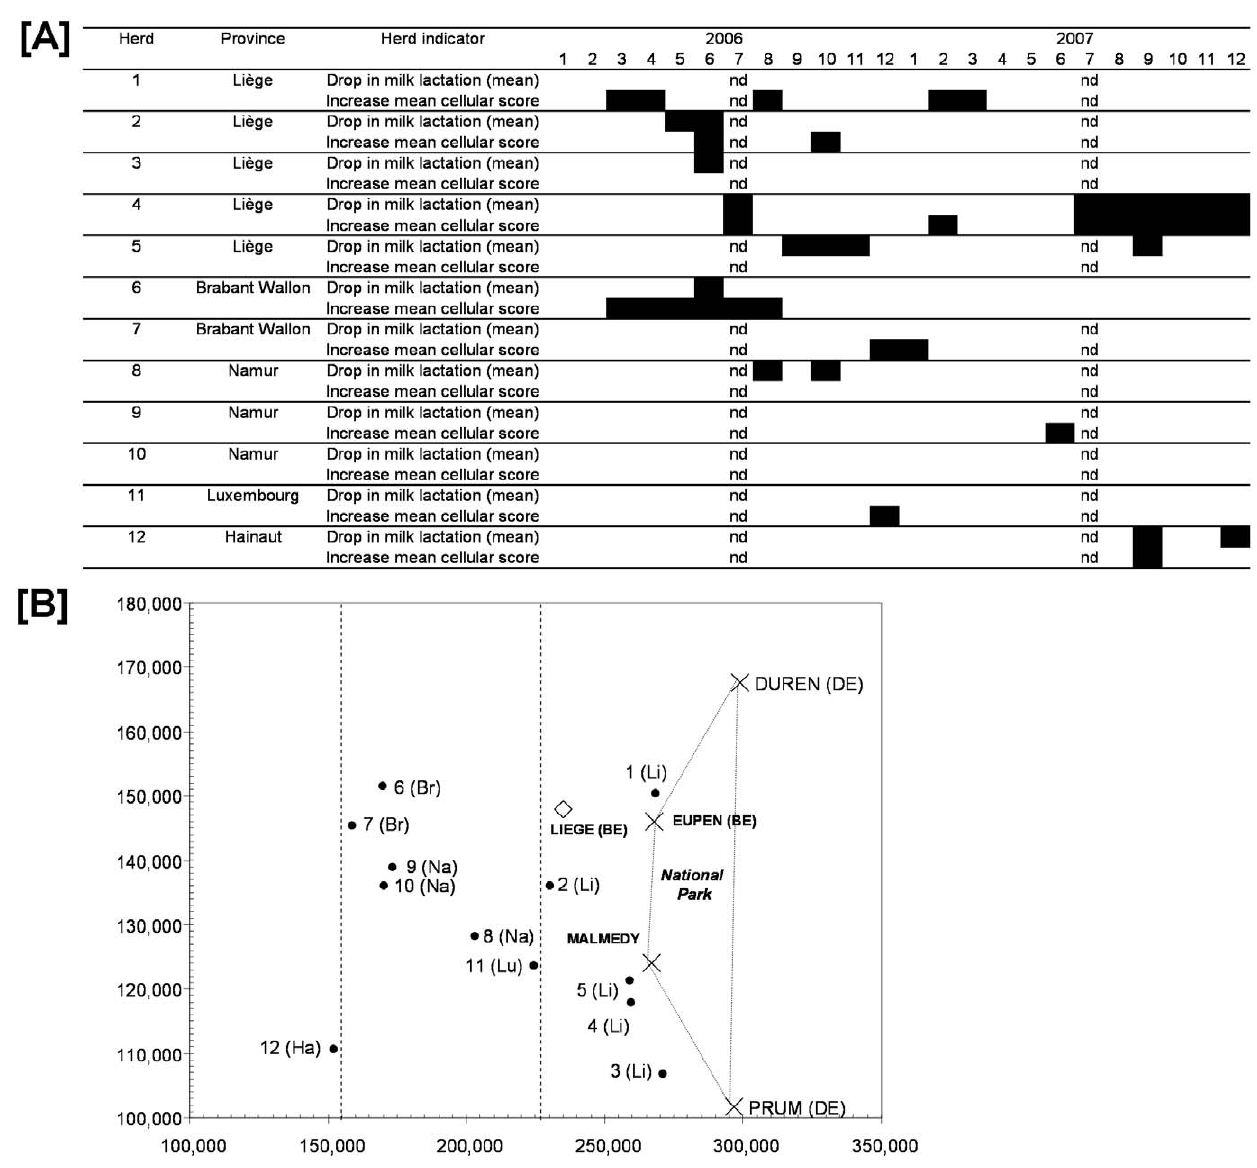
Figure 5. Temporal [A] and spatial [B] distributions of 2 disease non specific indicators at the dairy herd level. DMY: Drop in milk yield (mean by animal and monthly milk control expressed in kilograms); MCS: mean cellular score; & : DMY or increase in MCS; nd: Not determined; 1 to 12: Months for 2006 or 2007, respectively; For [B], X axis and Y axis are geographical Lambert coordinates; Li: Province of Lie`ge; Br: Province of Brabant Wallon; Na: Province of Namur; Lu: Province of Luxembourg; Ha: Province of Hainaut; BE: Belgium; DE: